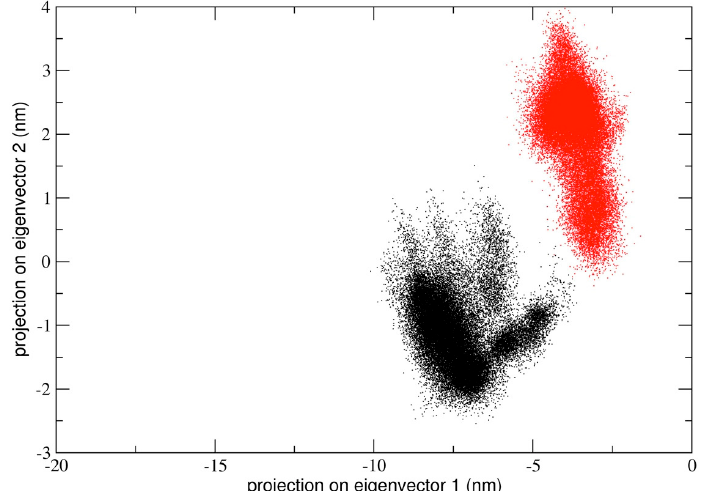
Figure 9. 2D projection of the binding pocket region trajectory in the dimeric form of the 3CLpro on the essential subspace along eigenvectors 1 and 2. The structural basin visited by chain A (black dots) and chain B (red dots) is highlighted in different colors.